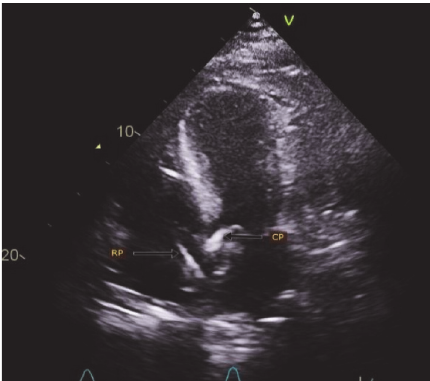
Figure 3: Echocardiographic view of the two pumps in place.